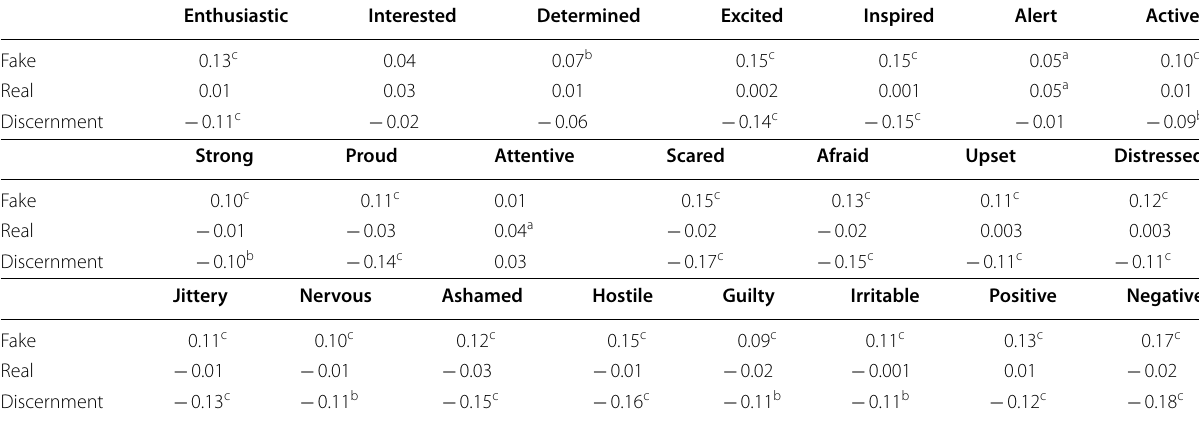
Fixed effects in model include PANAS item score, type of news headline, and interaction between PANAS score and type of news headline. Random effects include random intercepts for headline items and participants and by-item random slopes for PANAS scores and by-participant random slopes for type of news headline effects a p <